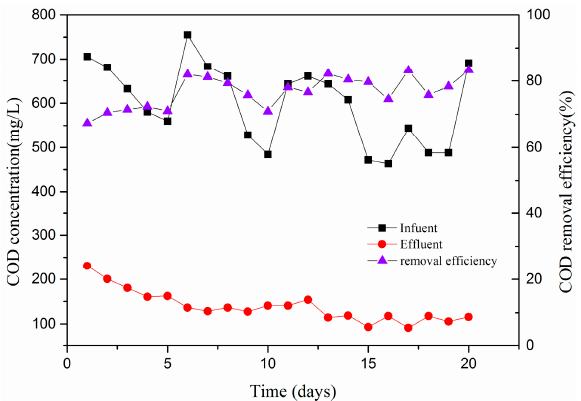
Figure 3. COD influent and effluent concentrations and removal rates under HRT: 16 h, aeration: 0.3 – 0.4 (L/min), DO: 2.45 ± 0.2 (mg/L).